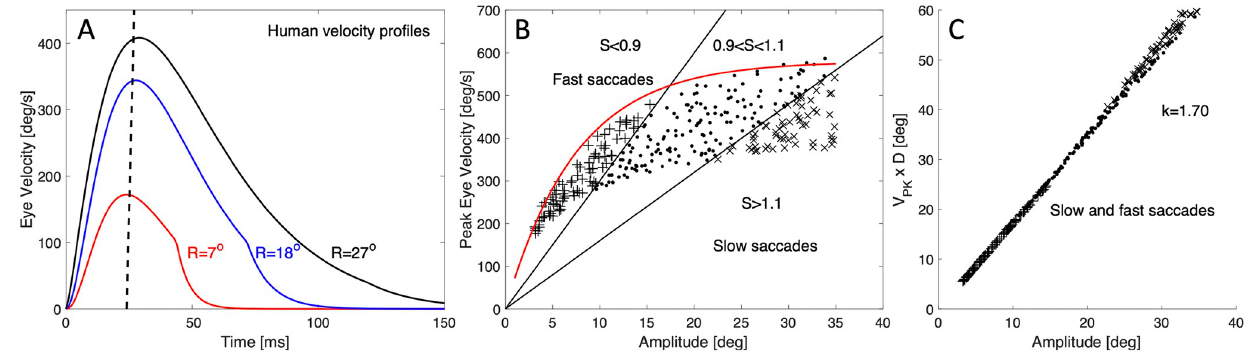
Fig 4. (A) Example velocity profiles for saccades of different amplitudes. Note that their peak velocity is reached at the same moment. (B) The amplitude-peak velocity relation (ordinate: 0–700 deg/s) for fast and very slow (diazepam-affected and fatigued) saccades (different symbols). The red curve delineates the fastest saccades possible for this human subject. Oblique lines separate sectors where saccades have a particular skewness. The lower the slope, the slower the saccades, and the larger its skewness. (C) Tight relation for saccades between amplitude and the product of peak velocity and duration. This relation expresses the fact that typical eye-saccades have single-peaked, ‘triangular-shaped’ velocity profiles. After: [43].